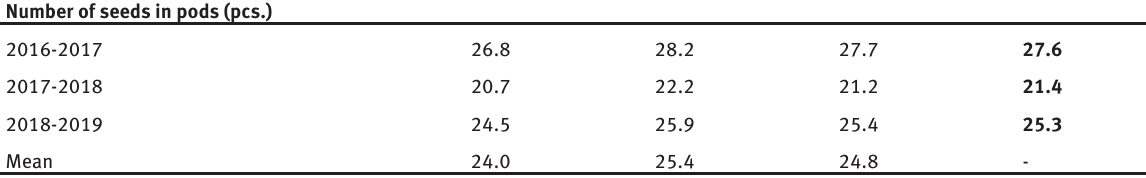
Number of seeds in pods